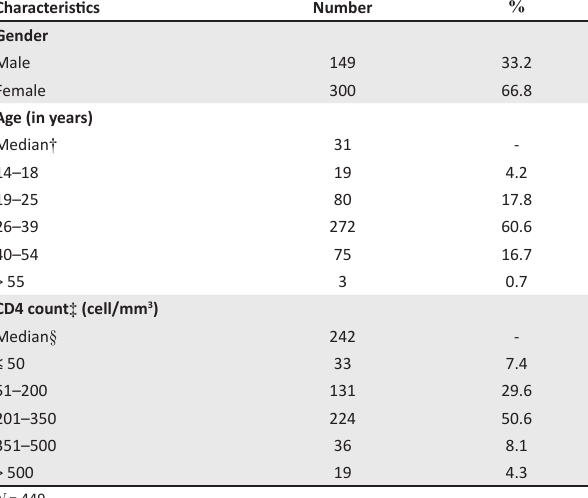
TABLE 1: Demographic and clinical characteristics of patients included in study at